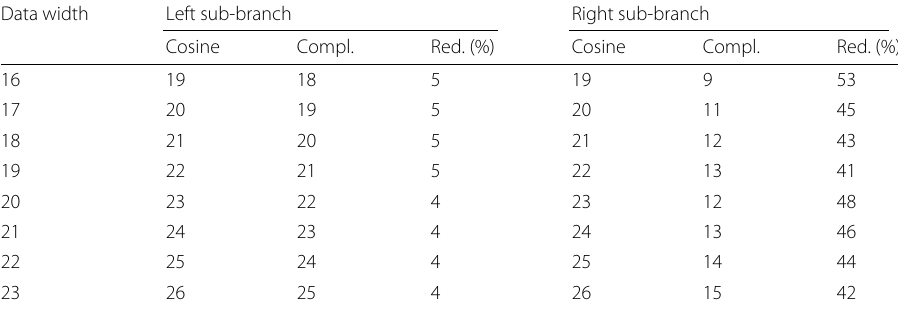
Table 3 Multiplicand width comparison of the left branch of generators with a tree structure of height 2